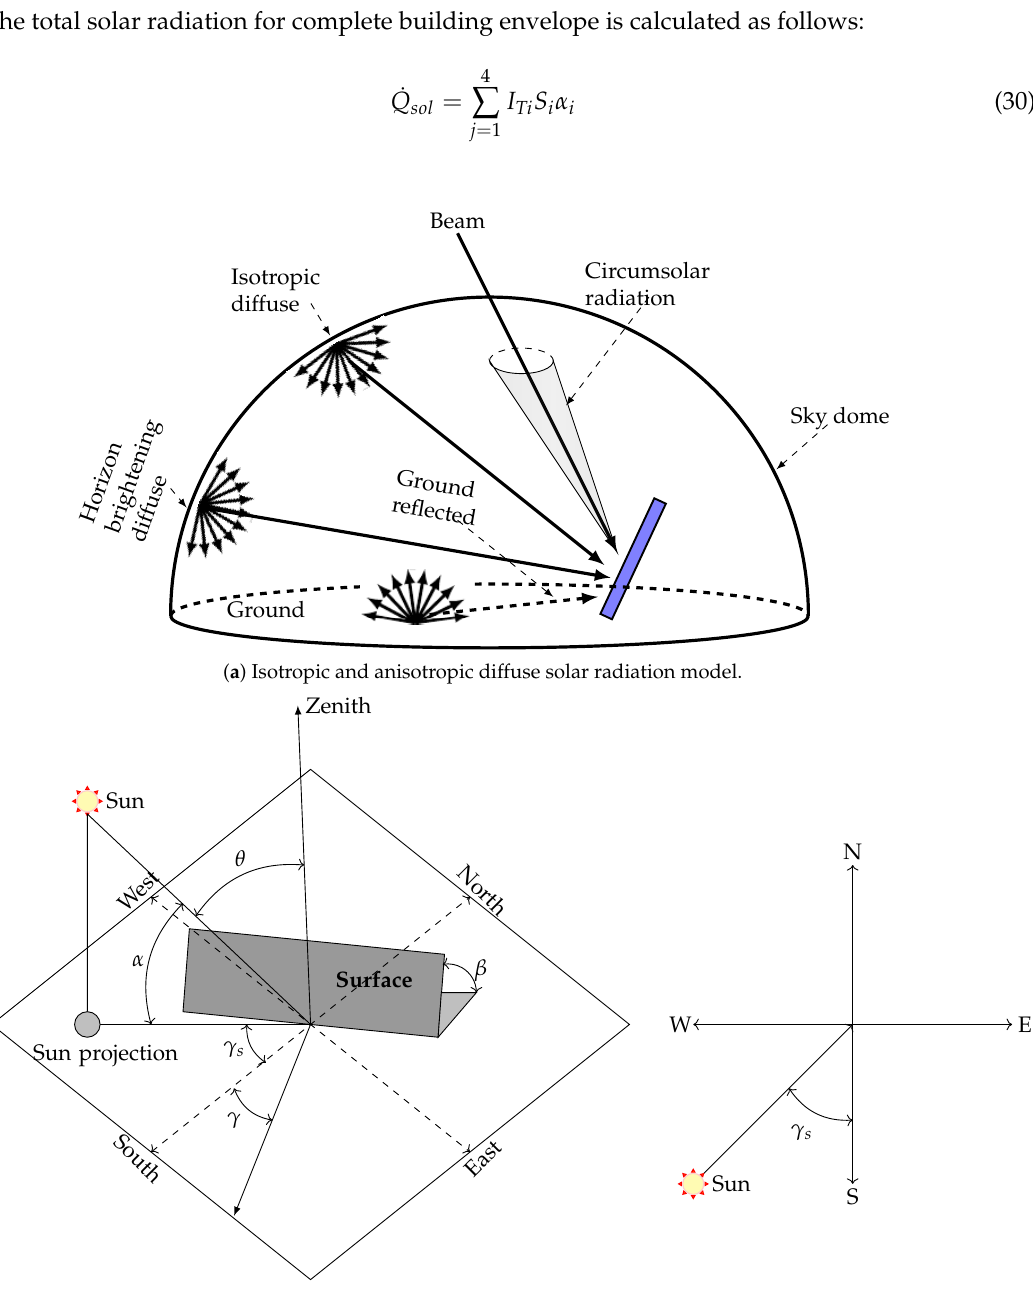
Figure 10. Solar sky models and solar angles